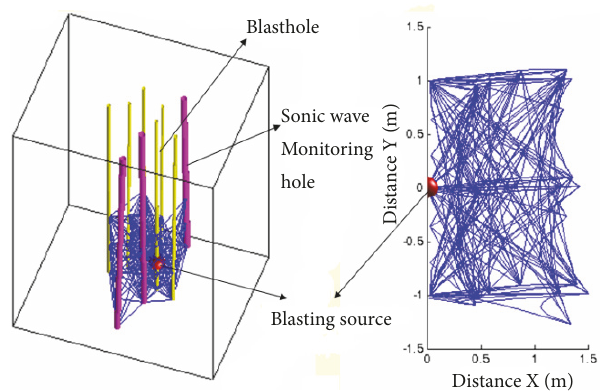
Figure 6: Three-dimensional illustration of locations of blasting source, blasthole, and sonic wave monitoring holes.